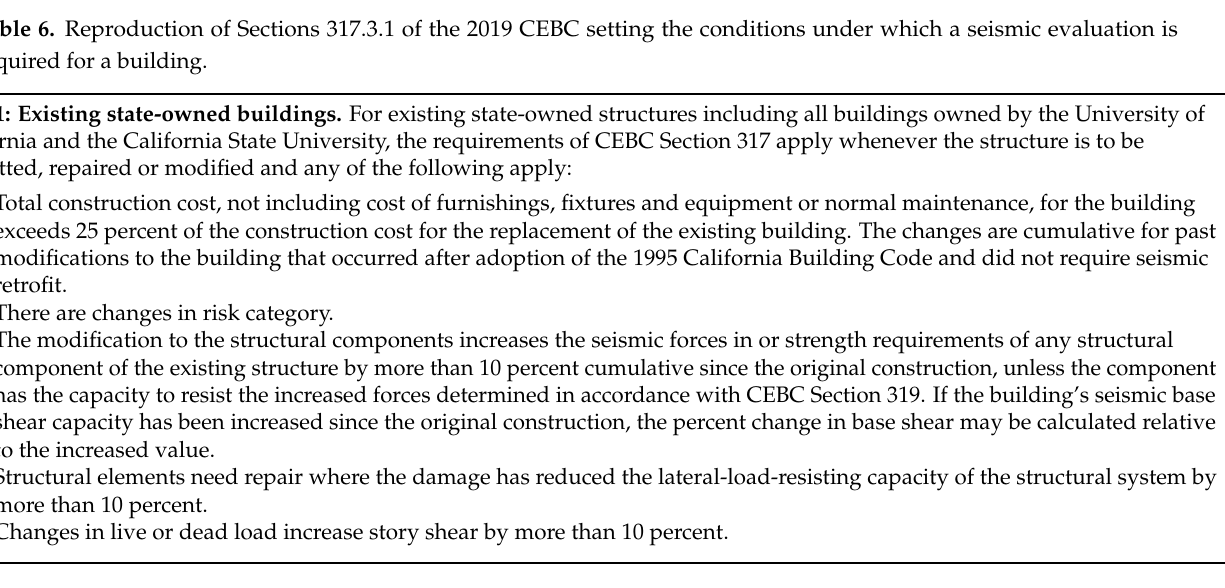
Table 6. Reproduction of Sections 317.3.1 of the 2019 CEBC setting the conditions under which a seismic evaluation is required for a